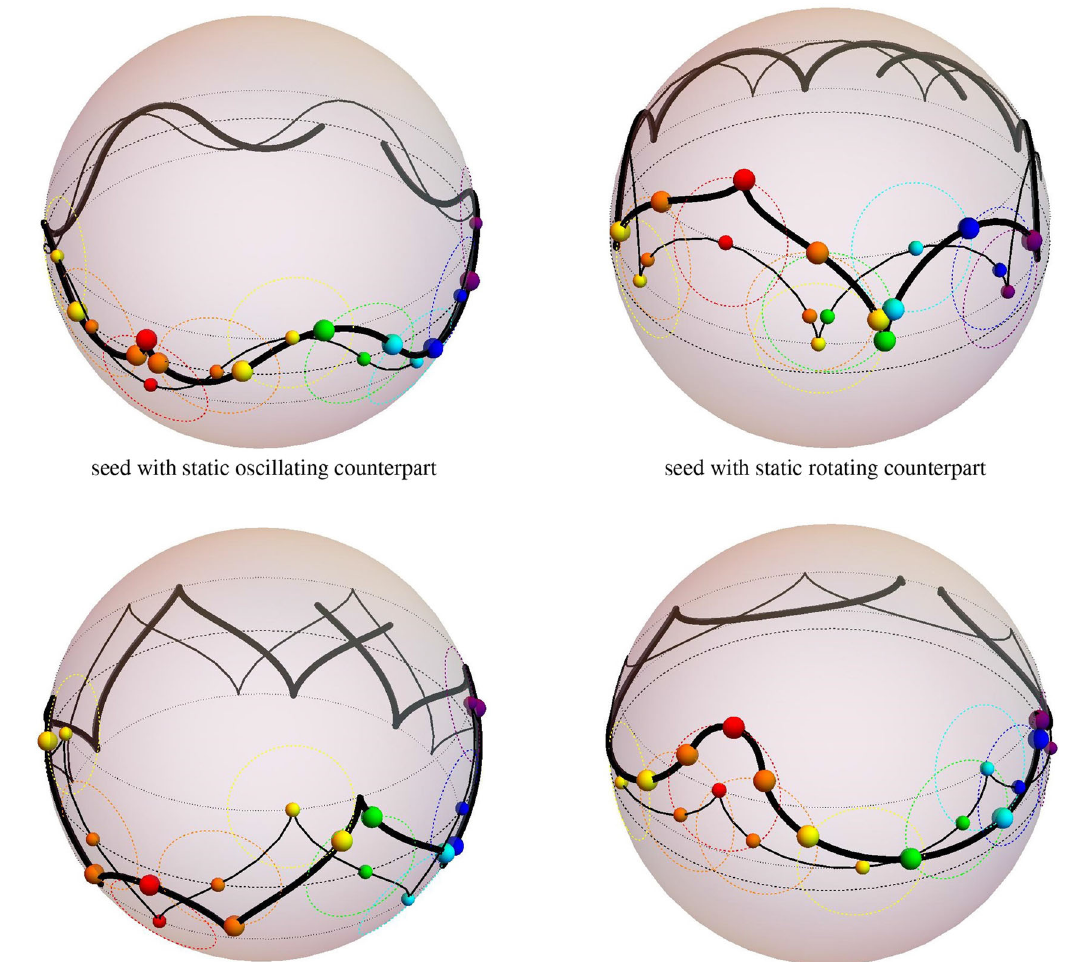
Fig. 1 The dressed elliptic string solutions